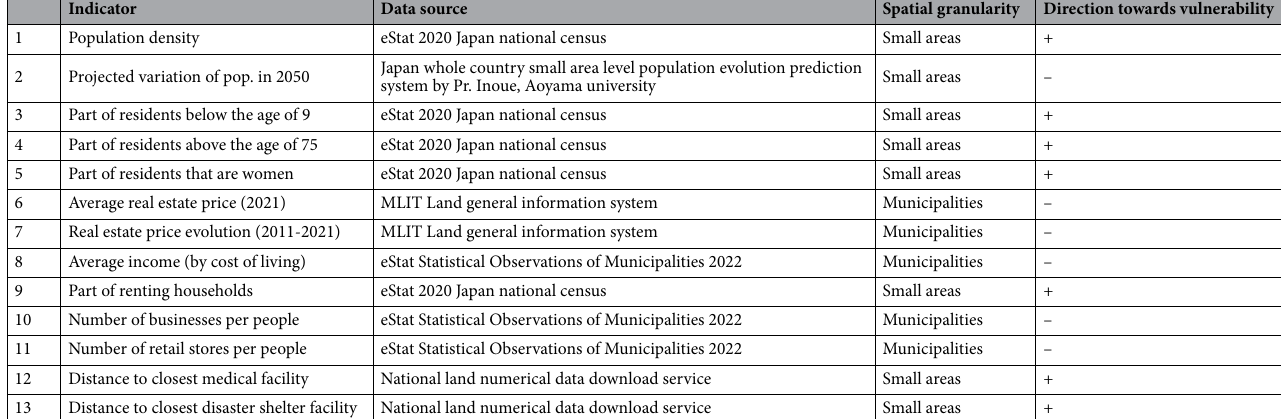
Table 2. List of selected indicators for the social vulnerability analysis, with data source, spatial granularity and assumed direction towards vulnerability (i.e. plus sign means that the large the quantity, the larger the social